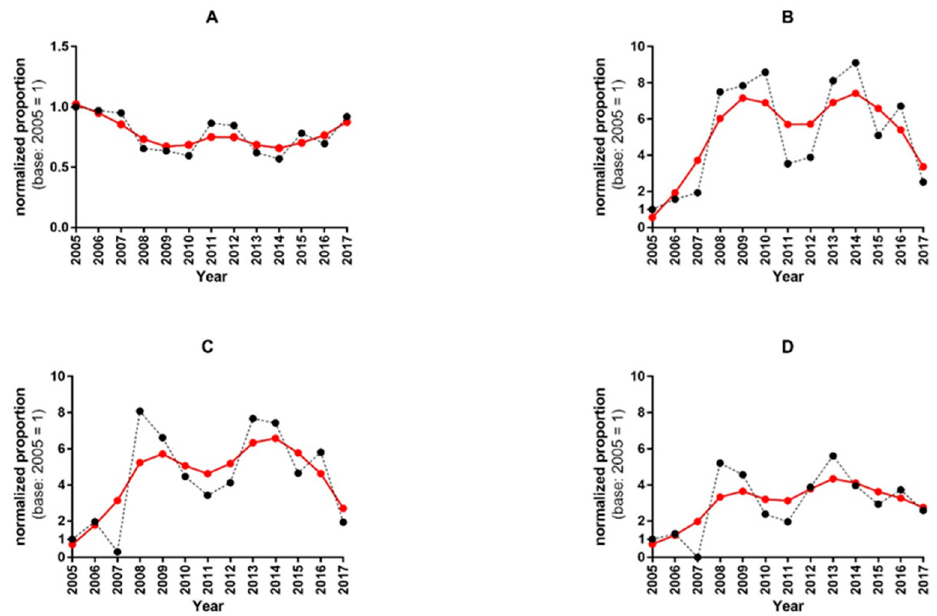
Figure 1. Time course of the normalized proportions and their trend lines in HI titres. The panels ( A – D ) display the normalized proportions (black dots) of negative (5), positive ( ≥ 1:10, ≥ 1:20), and high positive ( ≥ 1:40) HI titres respectively, with the trend curves (red dots) estimated by using the Hodrick–Prescott filter. Panel ( A ): the dynamics of the time series shows values that are almost always lower than the base 2005 values. After 2014, the trend seems to have turned upwards towards the initial base level. Panel ( B ): the time series of the positive titres ( ≥ 10) shows a bimodal pattern, with peaks in 2010 and 2014, preceded by huge upsurges in 2008 and 2013. Peaks in the trend curve were observed in 2009 and 2014. Panel ( C ): the positive titres ≥ 20 show a similar bimodal pattern in the time series, with peaks in normalized proportions occurring in 2008 and 2013. The trend curve shows two peaks in the same years as that of the positive titres ≥ 10. Panel ( D ): the time series of the normalized proportions of highly positive titres ( ≥ 1:40) displays its highest values in 2008 and 2013. In the trend curve, the first peak is delayed by one year (2009), and the second peak coincides with the year 2013.